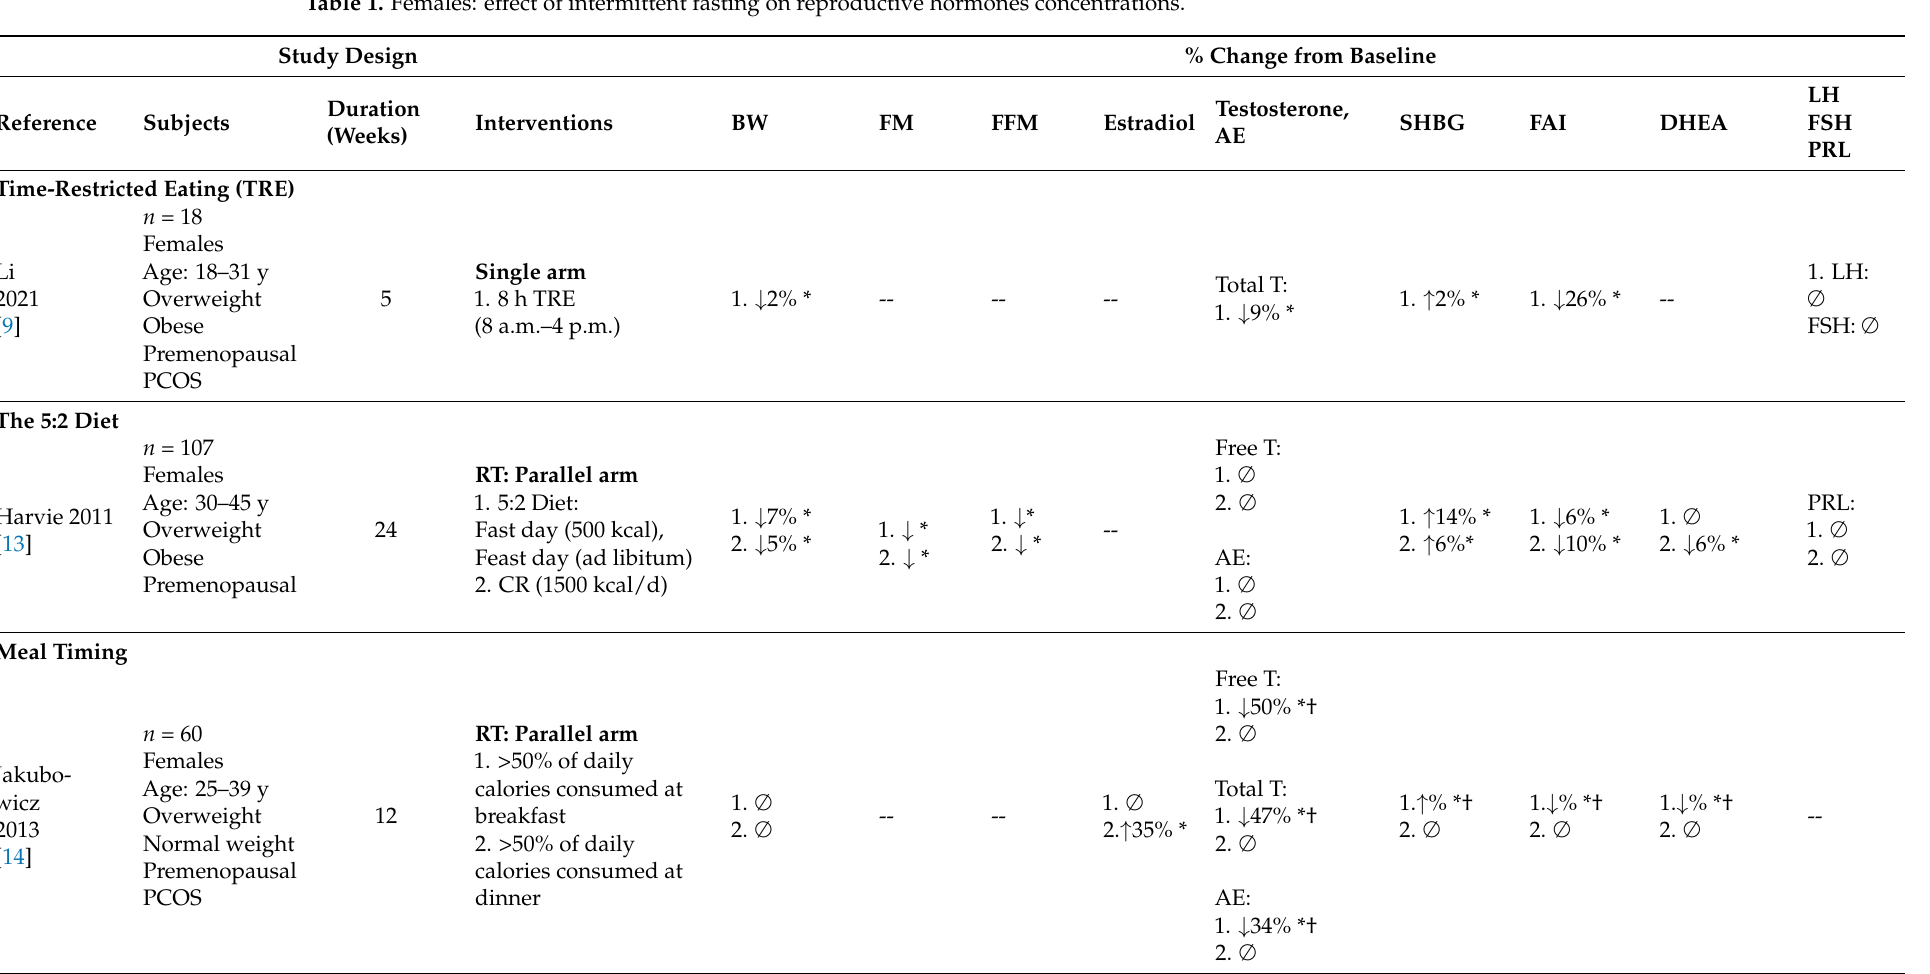
Table 1. Females: effect of intermittent fasting on reproductive hormones